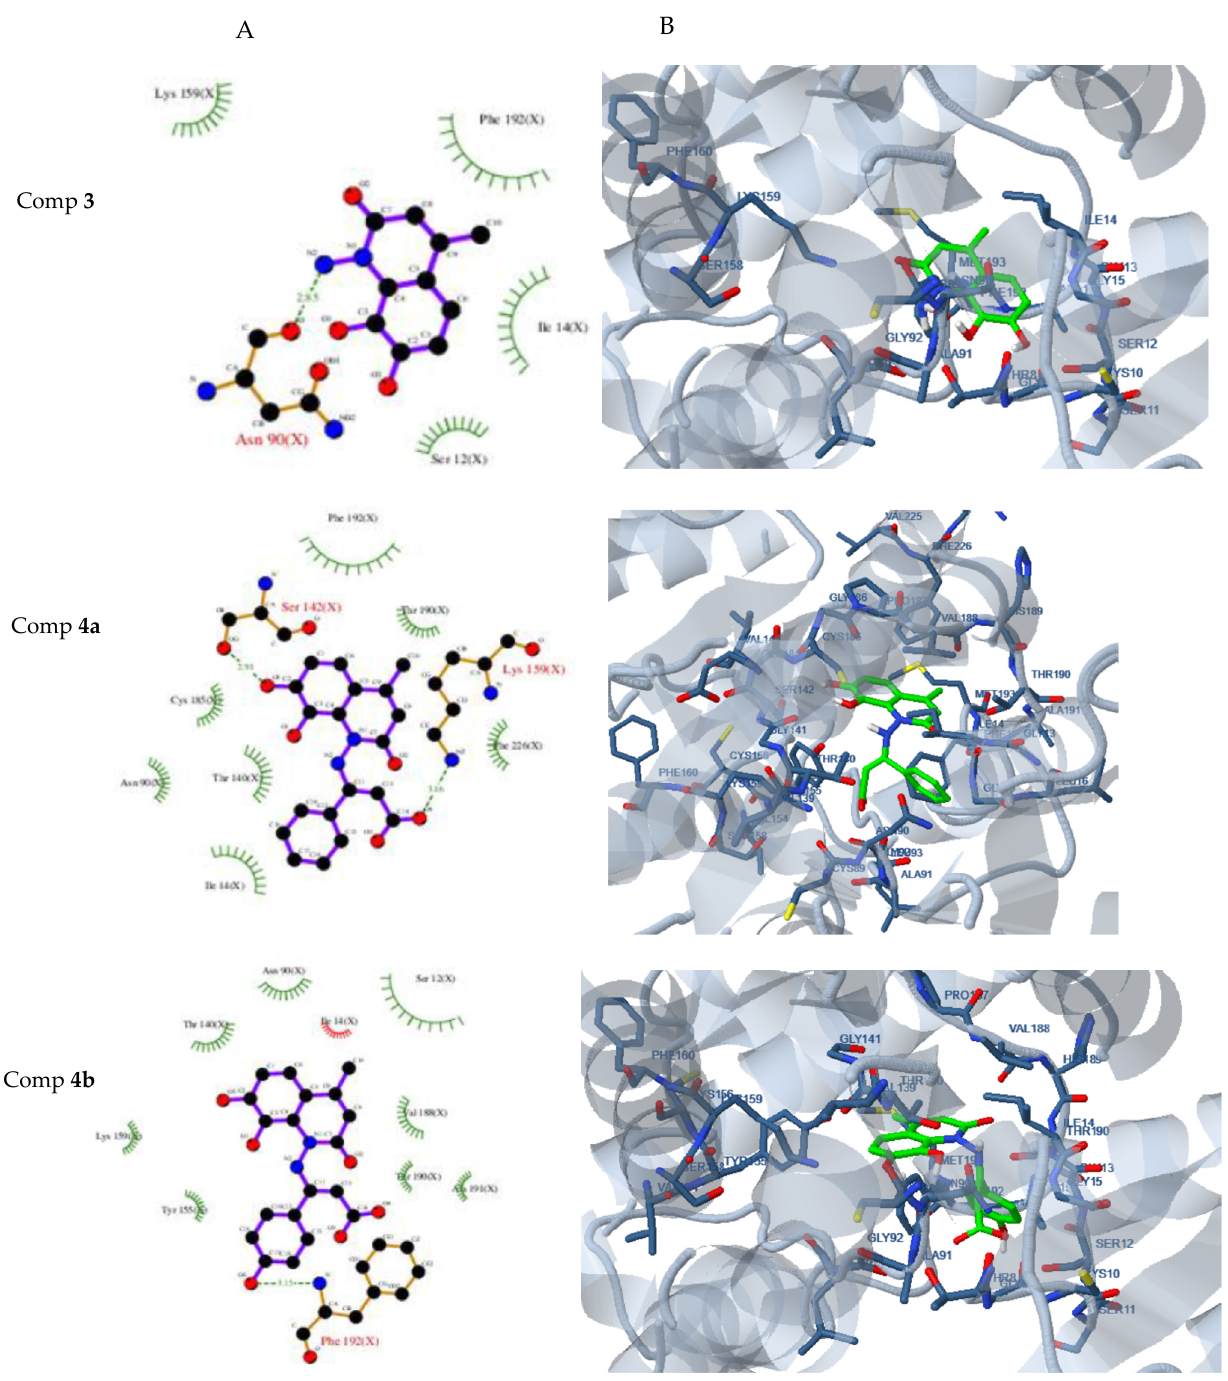
Figure 5. Interaction of docked compounds 3 , 4a and 4b inside the binding site of (3HB5): ( A ) 2D interaction; ( B ) 3D interaction.